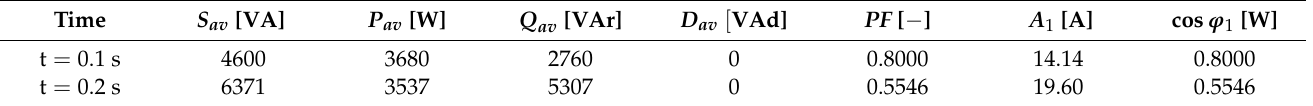
Table 13. Classical calculation before and after the change (at steady states).